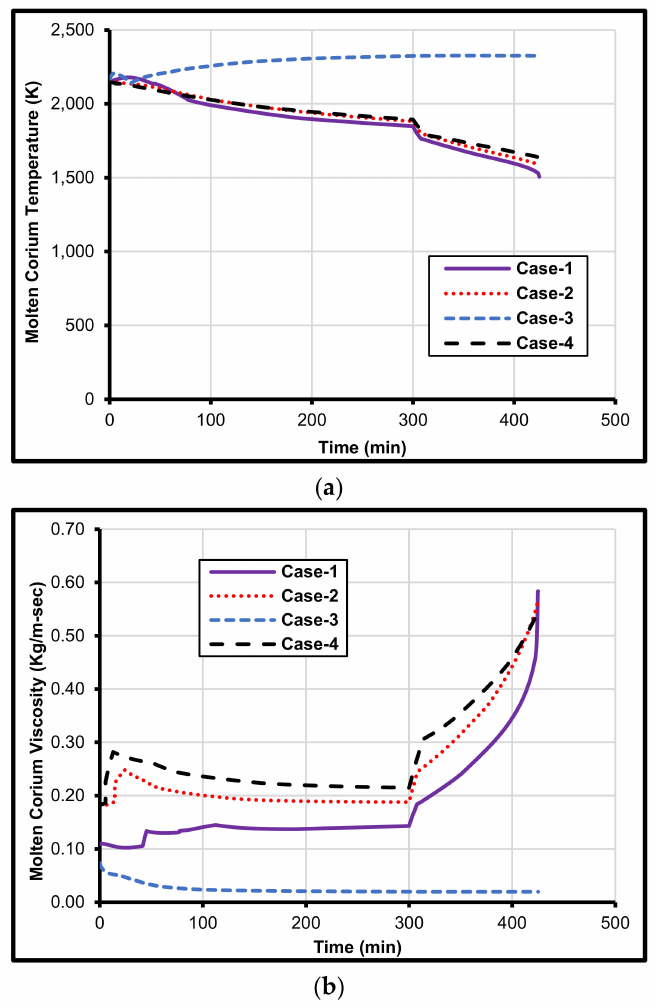
Figure 10. Effect of melt/corium composition during MCCI at 425 min on ( a ) temperature of corium and ( b ) molten corium